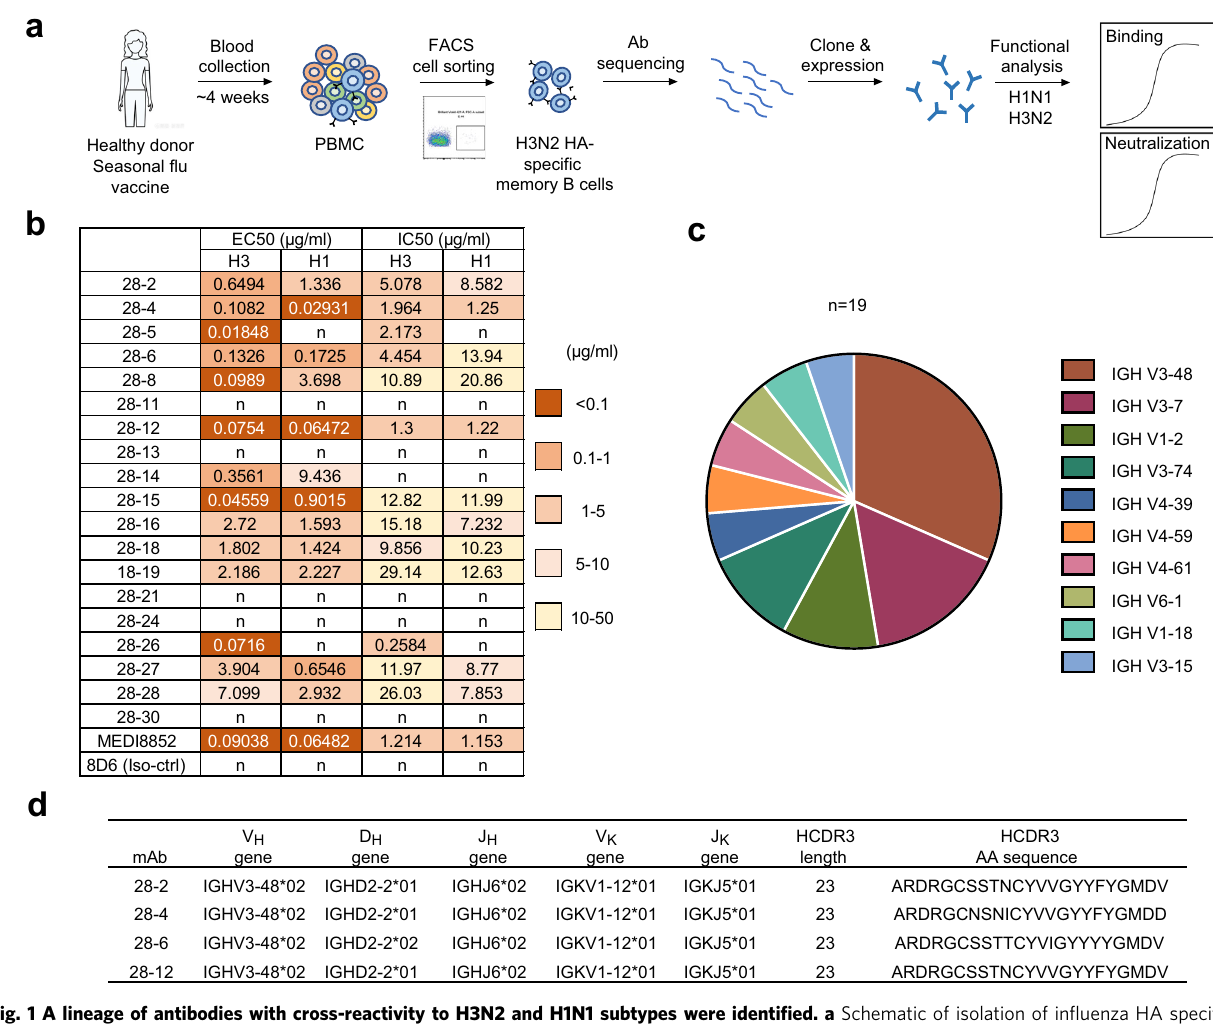
Fig. 1 A lineage of antibodies with cross-reactivity to H3N2 and H1N1 subtypes were identi fi ed. a Schematic of isolation of in fl uenza HA speci fi c antibodies from an individual vaccinated with trivalent inactivated in fl uenza vaccine. The isolated antibodies were tested for dose-dependent binding and neutralizing activities against group 2 HK/68 H3N2 and group 1 SC/09 H1N1 ( b ). 8D6, an unrelated HCV antibody was included as a negative control. The EC50 and IC50 values are shown into heatmap. n, not binding or not neutralizing. c Distribution of V gene families in heavy chains of all distinct clones ( n = 19). d Summary of the germline (V-D-J for heavy chain and V-J for light chain) and HCDR3 of V H 3-48/V K 1-12 lineage 1 mg/kg) and then challenged with a lethal dose of H1N1 and H3N2 viruses 24 h later. The administration of a lower dose of 28-12 (1 or 3 mg/kg) fully protected the mice from H1N1 (Fig. 3e, f) or H3N2 (Fig. 3a, b) infection. To evaluate the therapeutic ef fi cacy of 28-12, we administered 28-12 (25 mg/kg) at different time points following infection with SC/09 H1 or HK/68 H3 viruses. The data showed that all the mice survived when treated with 28-12 at day 2 post infection with HK/68 H3, and 80%